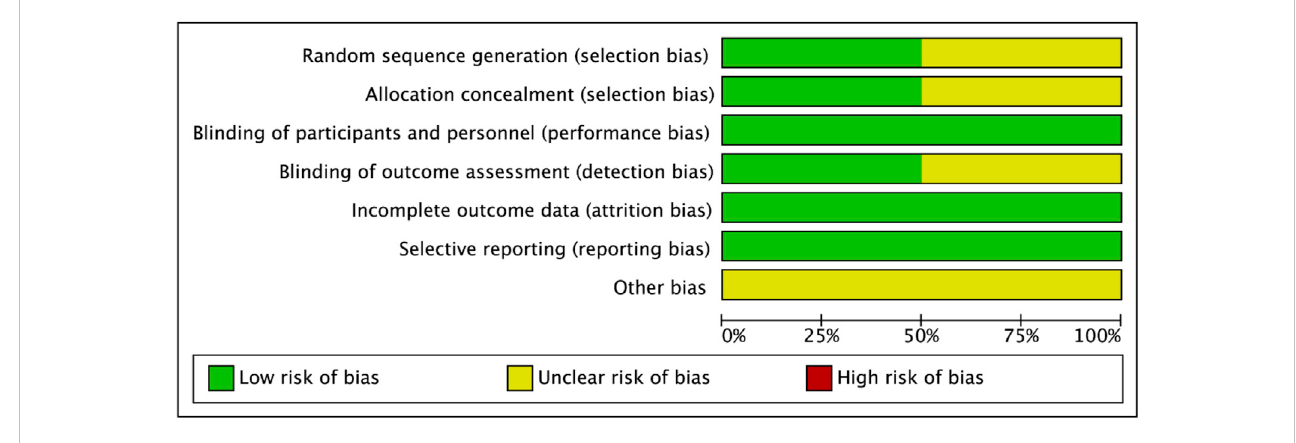
FIGURE 2 Risk of bias